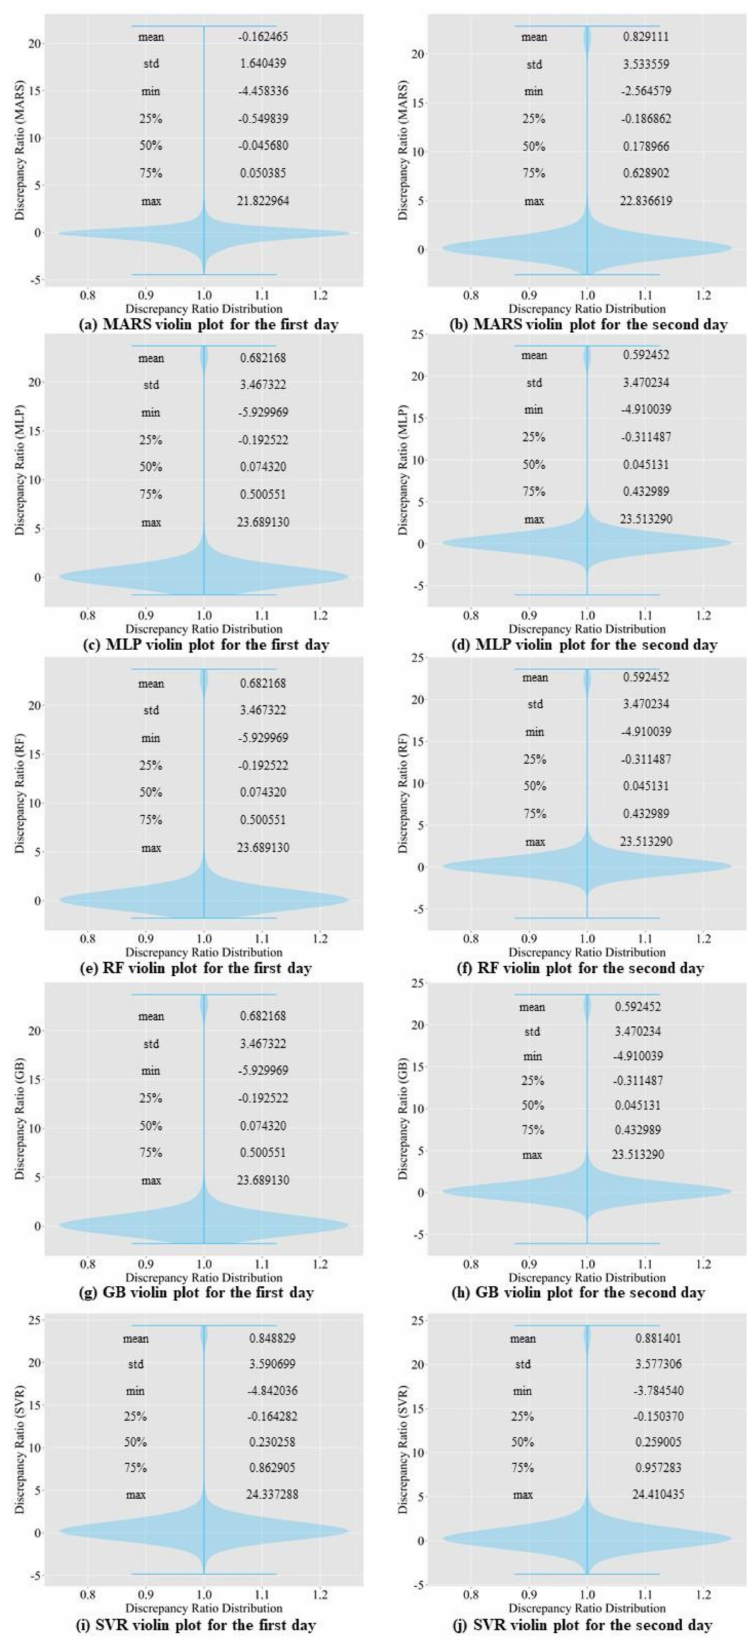
Figure 14. Violin plot for the discrepancy ratio for baseline